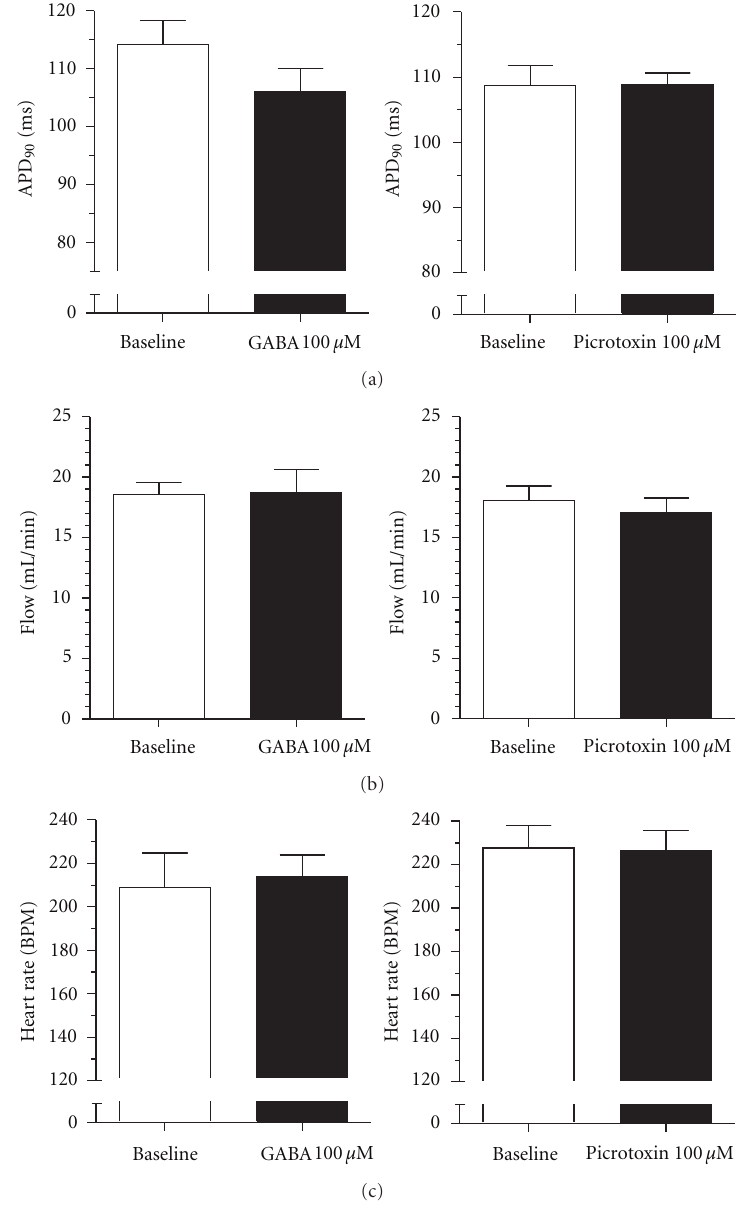
Figure 3: E ff ect of GABA 100 μ M (left column) or picrotoxin 100 μ M (right column) on isolated retrograde perfused female guinea pig hearts. Hearts were excised, mounted in a Langendor ff apparatus, instrumented, and perfused with krebs-henseleit solution at a constant pressure of 60mmHg as previously described [29]. Hearts were left to stabilize for a minimum of 30 min. After 20 min baseline recordings, where flow and heart rate was monitored, the hearts were paced from the right atrium for 2min at 240 BPM. This protocol was repeated in the presence of GABA 100 μ M or picrotoxin 100 μ M ( n = 5; GABA: 677 ± 99 g; Picrotoxin: 672 ± 100 g). GABA 100 μ M or picrotoxin 100 μ M produced no significant e ff ect on action potential duration (a), flow (b), and heart rate (c).